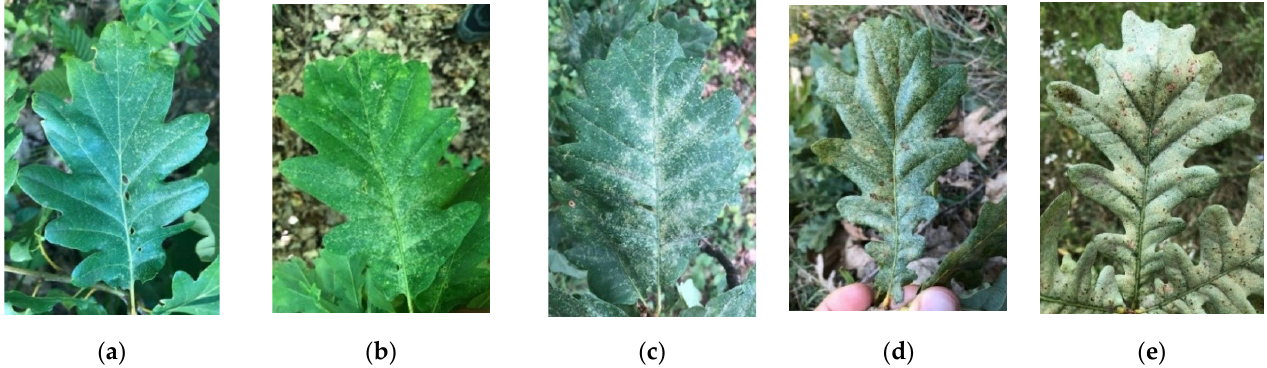
Figure 4. Scale showing different attack intensities of Corythucha arcuata nymphs and adults on oak leaves: ( a ) 5%; ( b ) 25%; ( c ) 50%; ( d ) 75%; and ( e ) 100%.